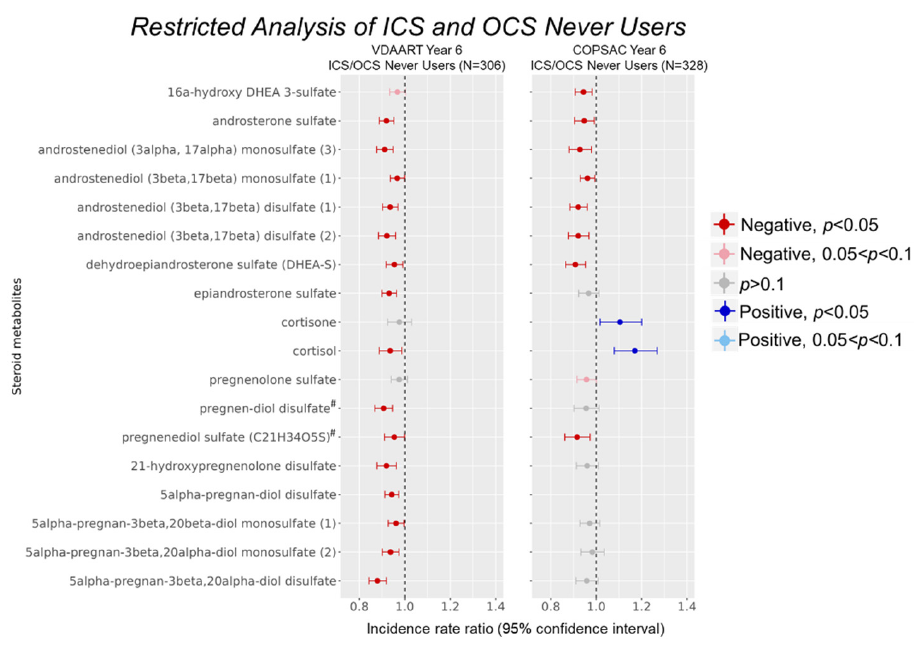
Figure 3. Reduced steroid levels were observed in restricted analysis of ICS and OCS non-users. ICS/OCS use between birth to age 6 was converted to a binary variable according to ever use (TRUE) or never use (FALSE). Steroid metabolite associations with infection proneness were assessed within never users of these medications to eliminate potential confounding by their use. Models were adjusted for the same covariates as in the original models. Metabolite names marked with a superscript hash sign (#) denote metabolite identification at tier 2 level (matching Metabolon database, details in Methods).